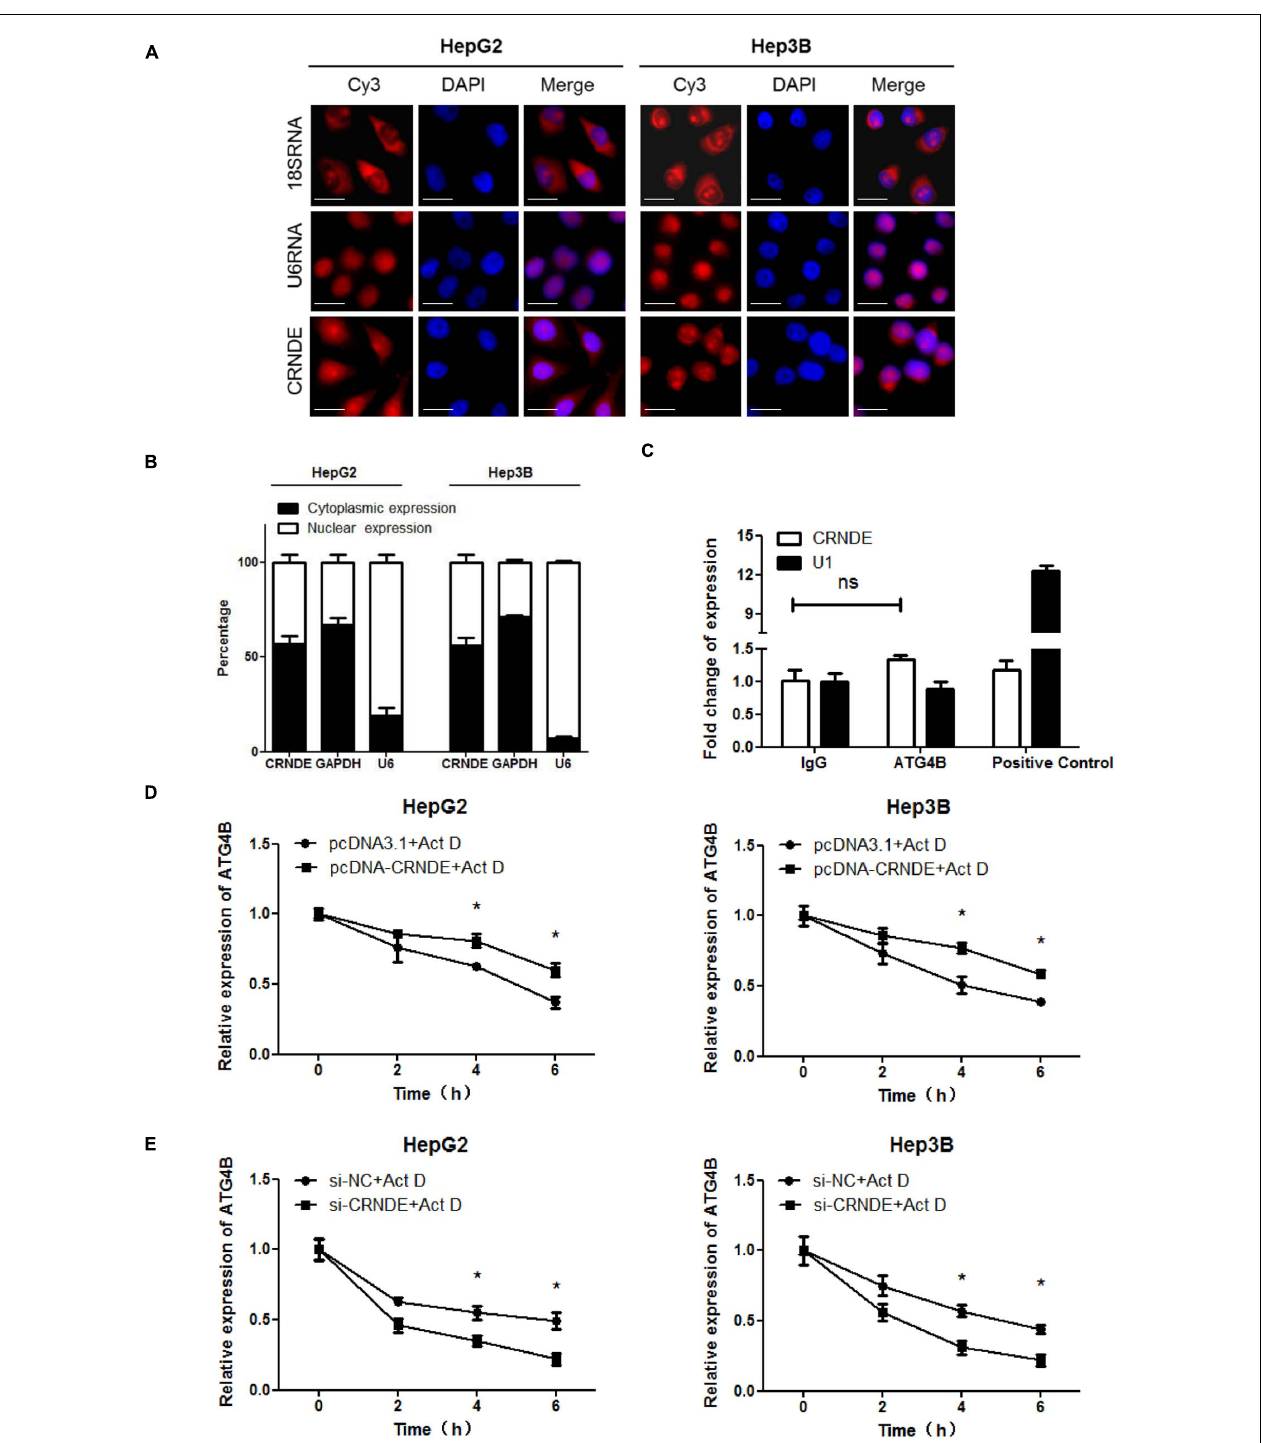
FIGURE 3 | CRNDE enhances the stability of ATG4B mRNA. (A) Subcellular distribution of CRNDE in HCC cells was assayed by FISH (Scale bar: 10 µ m). (B) The levels of nuclear and cytoplasmic CRNDE in HCC cells were tested by qPCR. GAPDH RNA and U6 RNA were used as cytoplasmic and nuclear RNA controls, respectively. (C) The level of CRNDE in the co-immunoprecipitates with anti-ATG4B antibody in HepG2 cells was examined by RIP assay. SNRNP70 (binding to U1 snRNA) and IgG were used as positive control and negative control, respectively. (D,E) After transfected with pcDNA-CRNDE (or pcDNA3.1) (D) or si-CRNDE (or si-NC) (E) for 18 h, HepG2 and Hep3B cells were treated with 5 µ g/mL actinomycin D (Act D) for the indicated times, and then the level of ATG4B mRNA was detected by qPCR. pcDNA-CRNDE, pcDNA3.1, si-CRNDE and si-NC were the same as the description in Figure 1 ; ns, no significance; * P < 0.05.